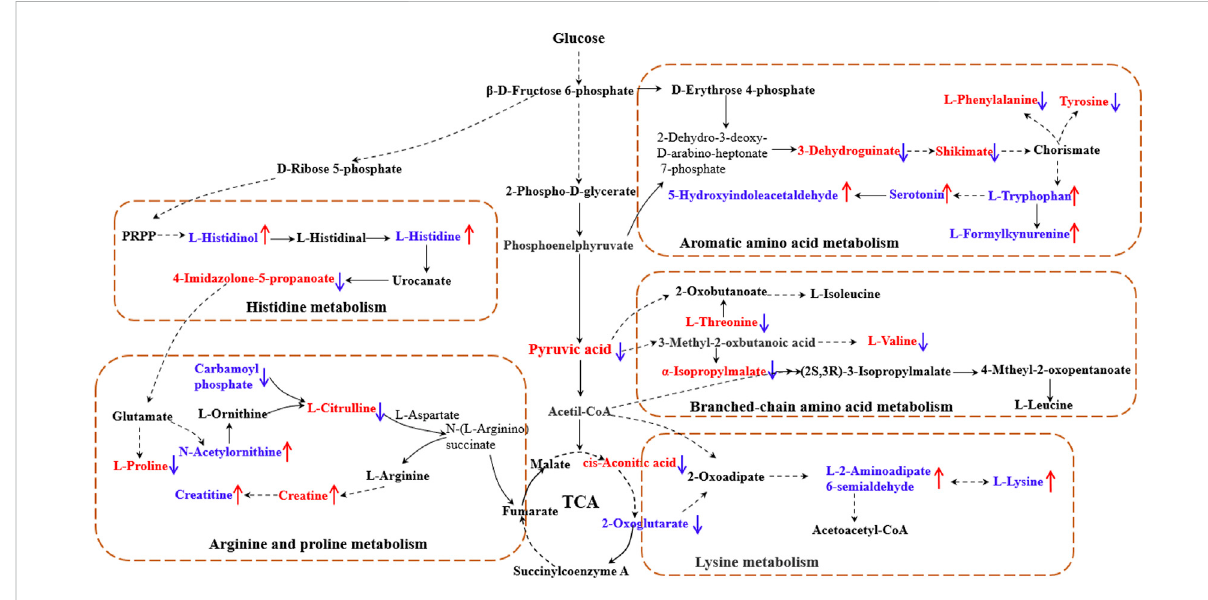
FIGURE 9 Network mechanism of MLs for the treatment of T2D (The solid line is a one-step reaction, and the dashed line is a multistep reaction. Red and bluedenotedifferentialmetaboliteswithsigni fi cantly increased anddecreasedcontentsintheserum ofT2Drats." ↑ "and" ↓ "represent thedifferential metabolites that are increased and decreased in the serum of T2D rats after the ML treatment,